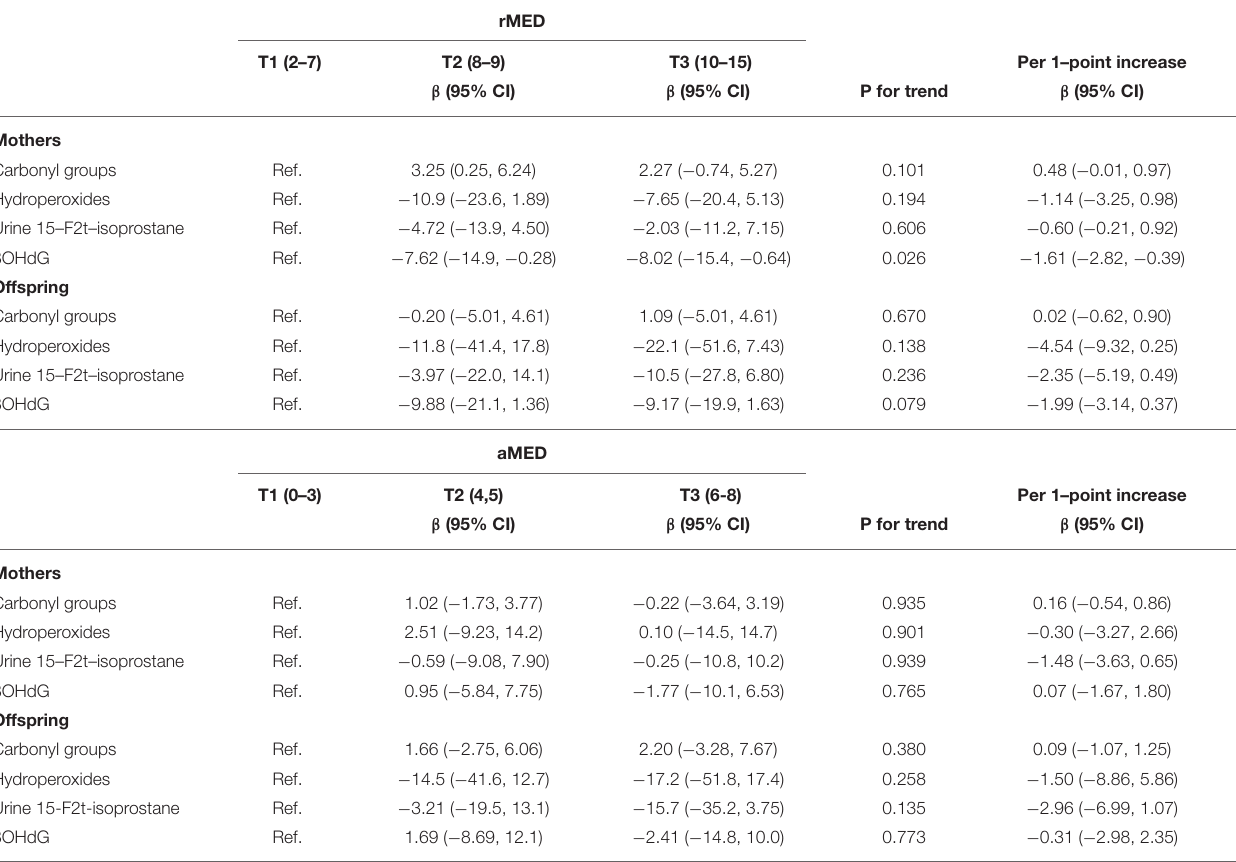
TABLE 3 | Associations between maternal rMED and aMED indices in pregnancy and the biomarkers of oxidative stress in mothers and their offspring. The NELA